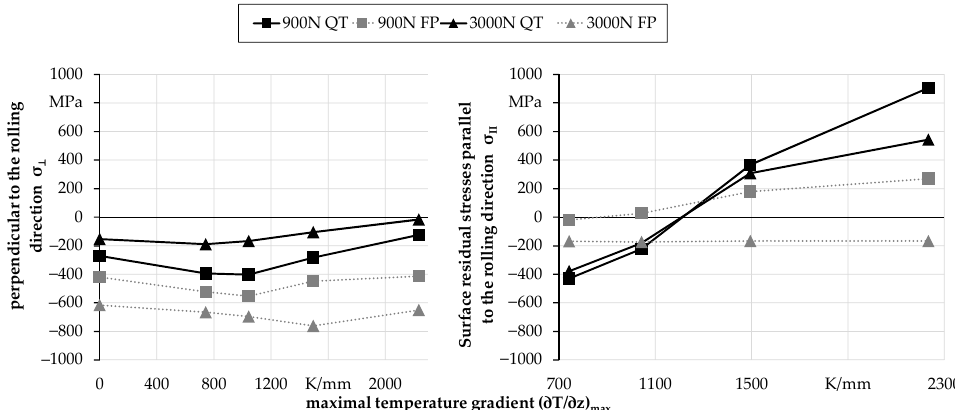
Figure 9. Process Signature for the laser-combined deep rolling process.